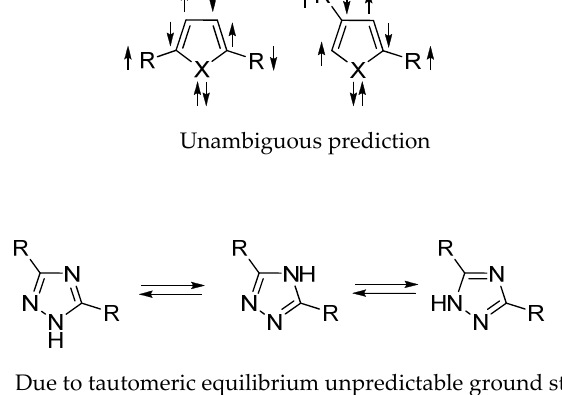
Figure 7. Prediction of the sign of the exchange coupling (R: nitronyl nitroxide or iminonitroxide moieties).